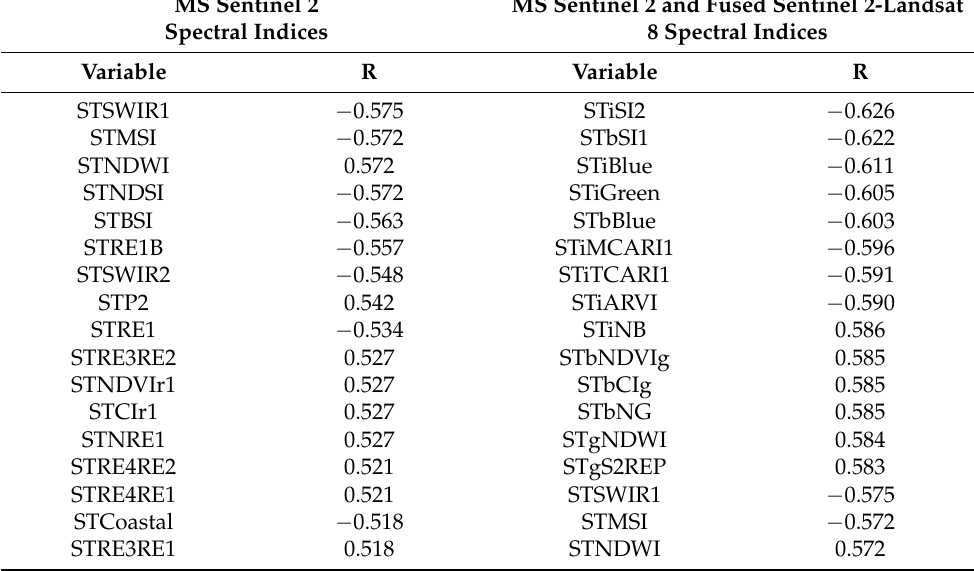
Nomenclature of the variable in Table 3: remote sensing images (abbreviation in Table S1) + spectral index (abbreviation in Table S1). Abbreviations: R, Spearman’s rank correlation